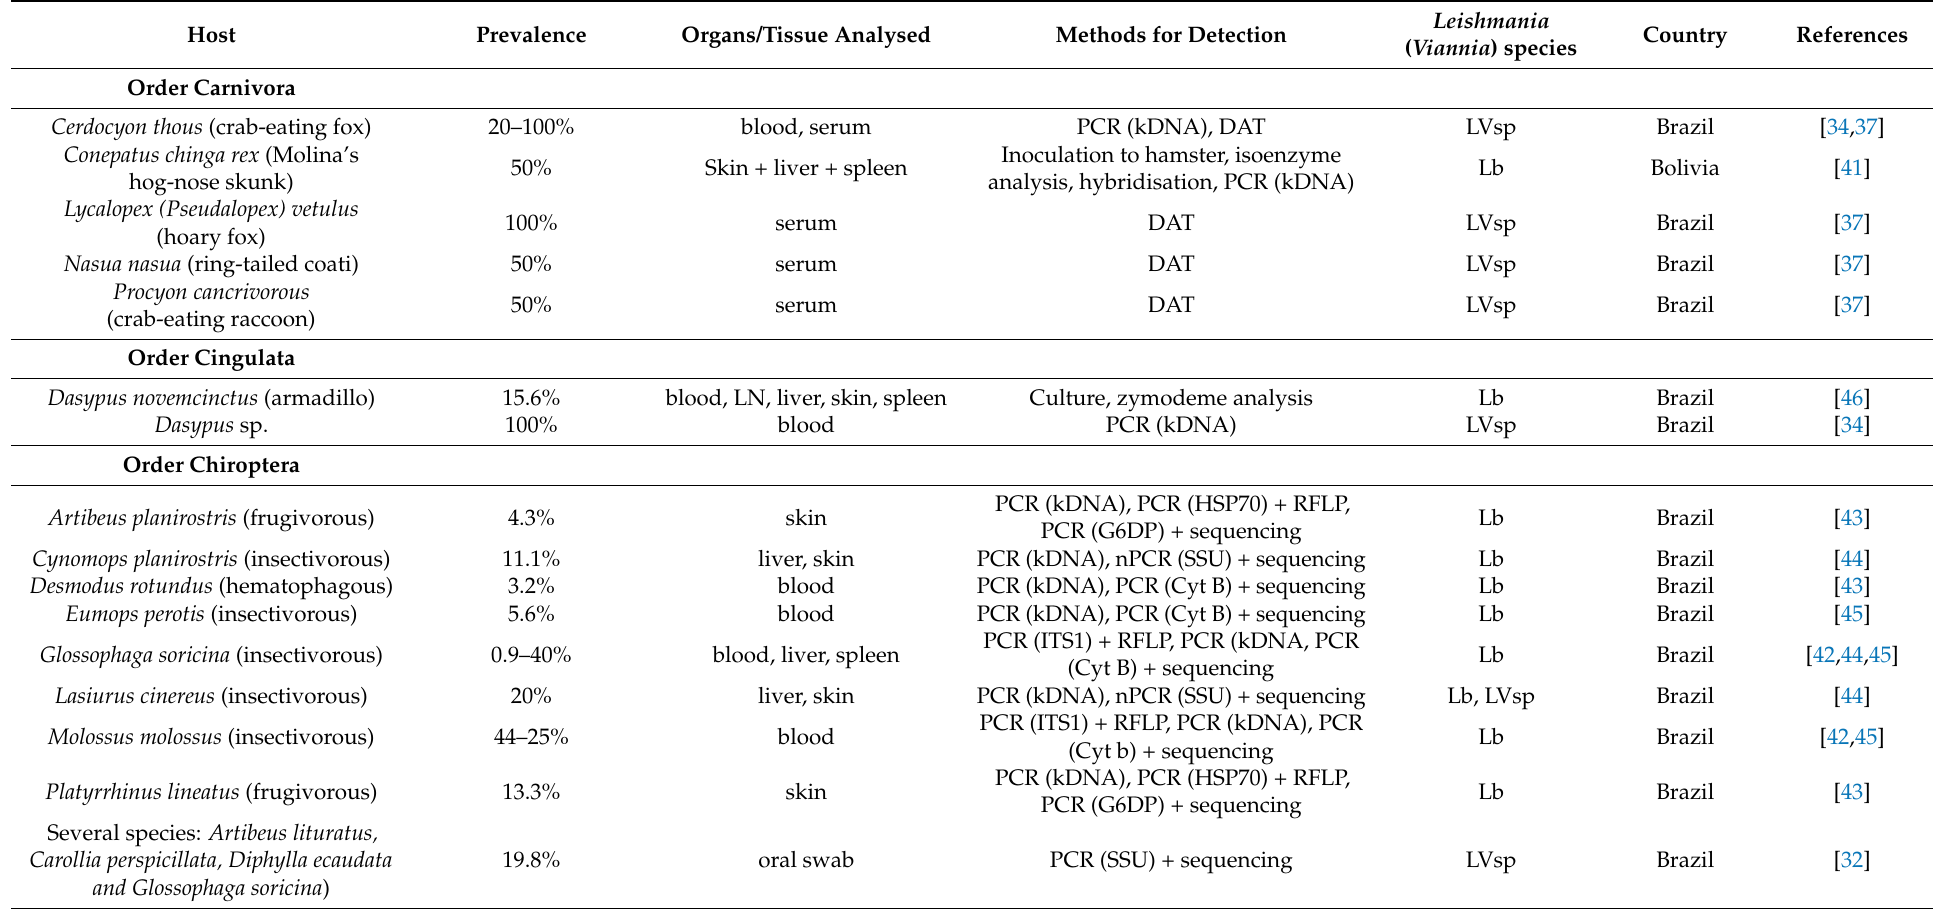
Table 2. Wild animals reported infected with zoonotic Leishmania ( Viannia ) species. Organs or tissues where the parasite was detected are indicated, as well as the techniques employed for detection. L ( Viannia ) species are as follows: Lb: L. braziliensis , Lg: L. guyanensis , LVsp: Leishmania ( Viannia ) spp., Lsp: Leishmania sp., Lpa: L. panamensis , Lpe: L. peruviana , Ln: L. naiffi , Ls: L. shawi and Ll: L. lainsoni